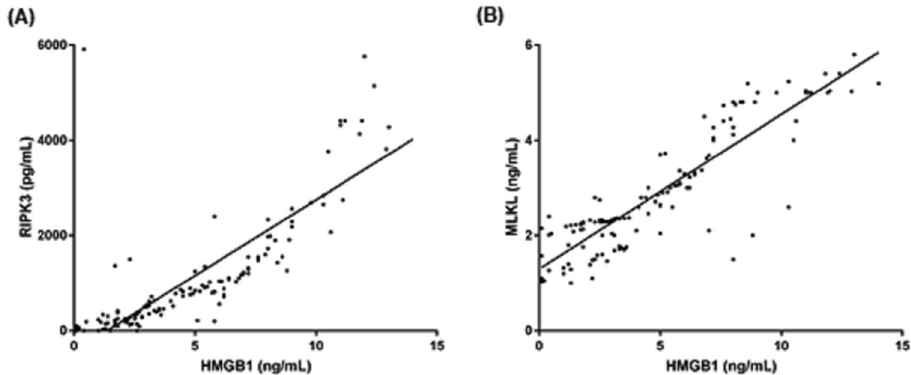
Figure 4. Correlation between plasma levels of HMGB1 and receptor-interacting kinase 3 (RIPK3) (A) and mixed lineage-like-domain protein (MLKL) (B) in patients with sepsis from the derivation cohort (n = 142) [RIPK3; slope 318.5 (95% confidence interval (CI): 279.6–357.4), R 2 : 0.6156 ( P < 0.001), Pearson’s: 0.807 ( P < 0.001), Spearman’s rho: 0.885 ( P < 0.001)] [MLKL; slope = 0.3251 (95% CI: 0.2790–0.3532), R 2 : 0.7890 ( P < 0.001), Pearson’s: 0.888 ( P < 0.001), Spearman’s rho: 0.852 ( P < 0.001)].